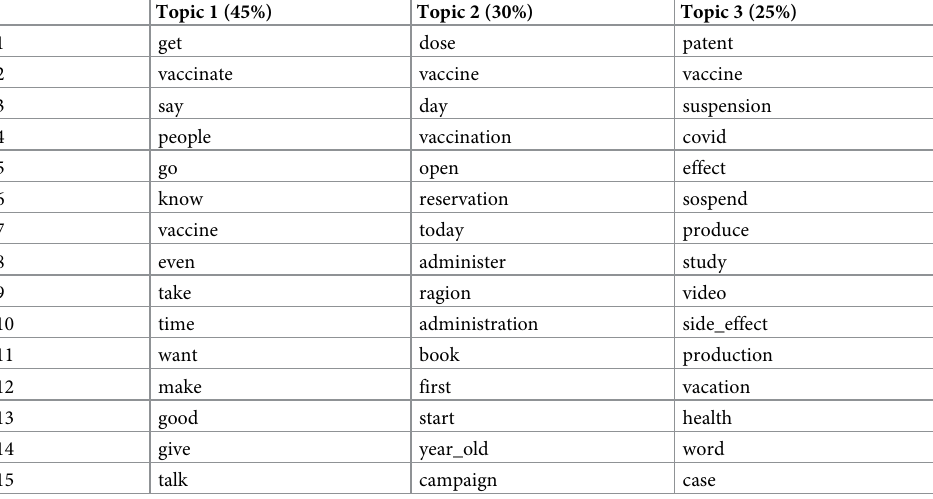
Table 5. LDA results: Percentage size and first 15 words of each